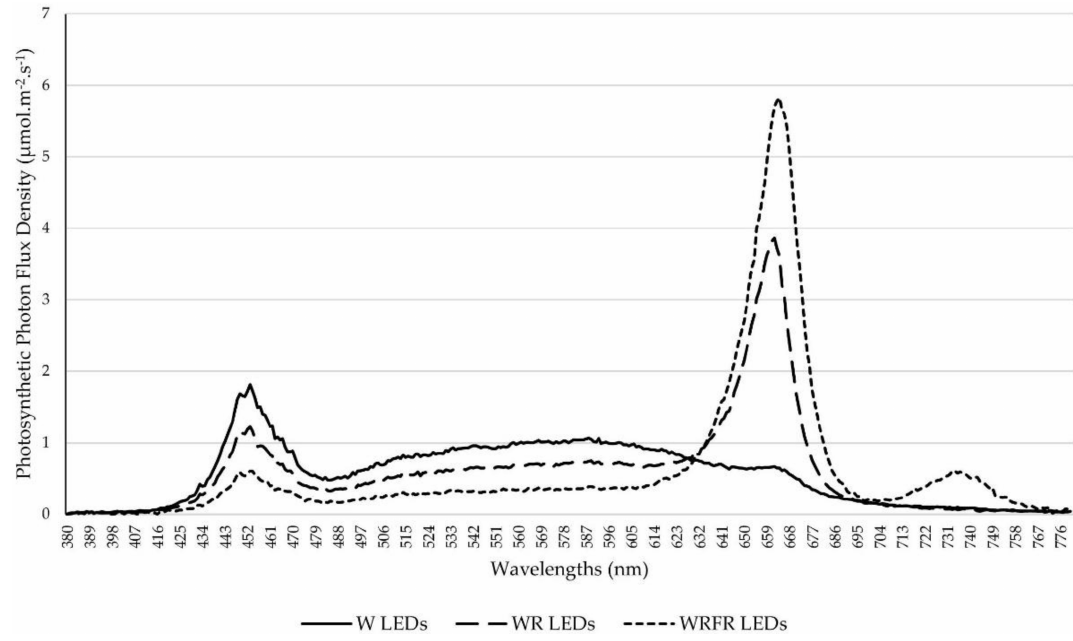
Figure 1. Spectral distribution of three light conditions from white (W), red (R), and far-red (FR) light-emitting diodes (LEDs). Table 1. Spectral characteristics of the three light conditions